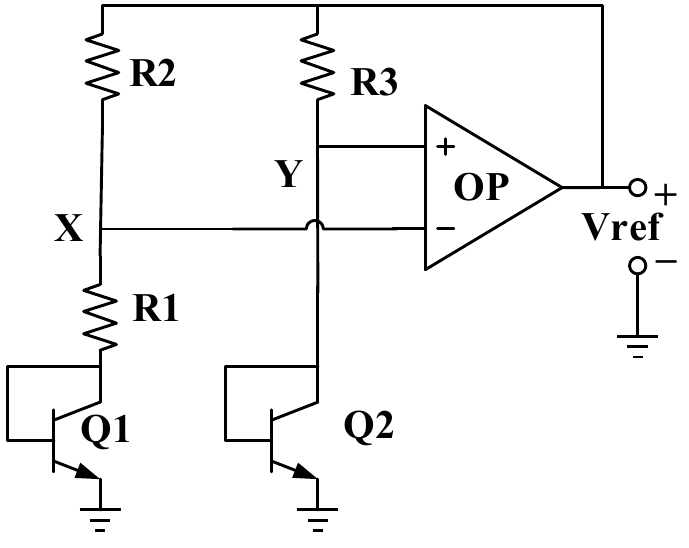
Figure 1. Traditional BGR structure.